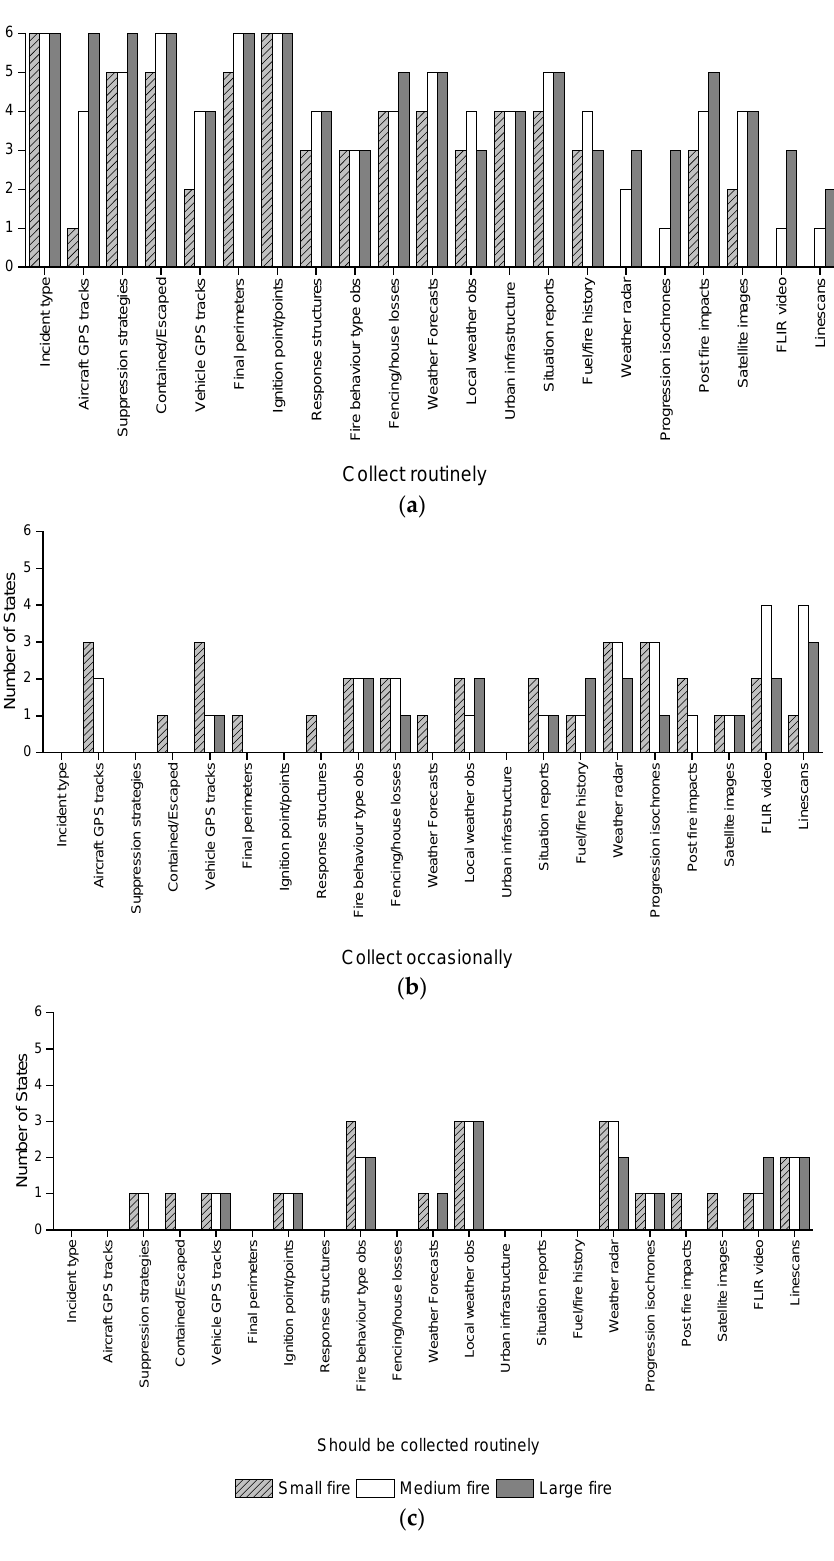
Figure 1. Responses from fire and land management agencies in Australia. Clustered columns show the number of states, which collect specific data type routinely ( a ), occasionally ( b ) or should collect routinely ( c ). The responses are given for small, medium and large fires.